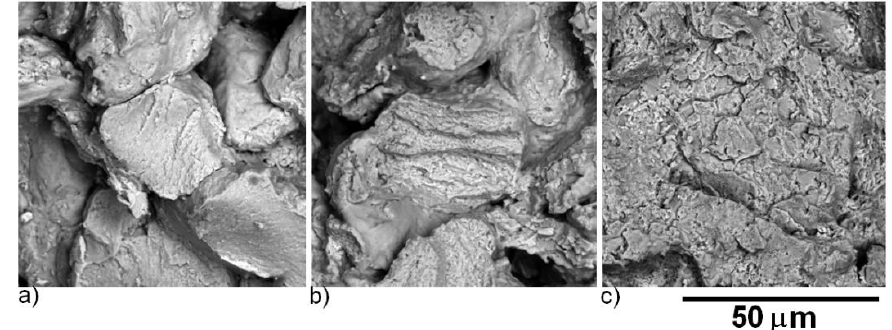
Figure 15. SEM (BSE) micrographs of fracture surfaces of the SPS compacted Fe28Al from the 1-h milled powder sintered at ( a ) 900 °C, ( b ) 1000 °C, and ( c ) 1100 °C.